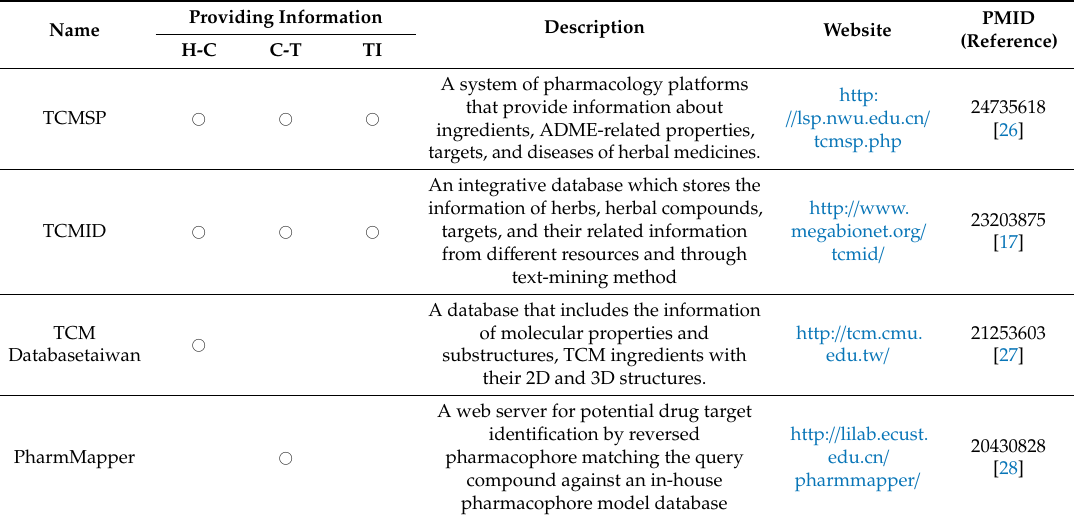
Table 1. The public databases related to traditional herbal medicine-network pharmacology (THM- NP) studies.